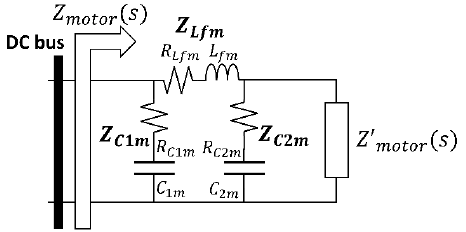
( d ) Figure 23. Frequency response of the small-signal input impedance, Z´ motor (s) , of the motor drive- electric motor-vehicle system in both motor mode, ( a ) gain and ( b ) phase; and generator mode, ( c )